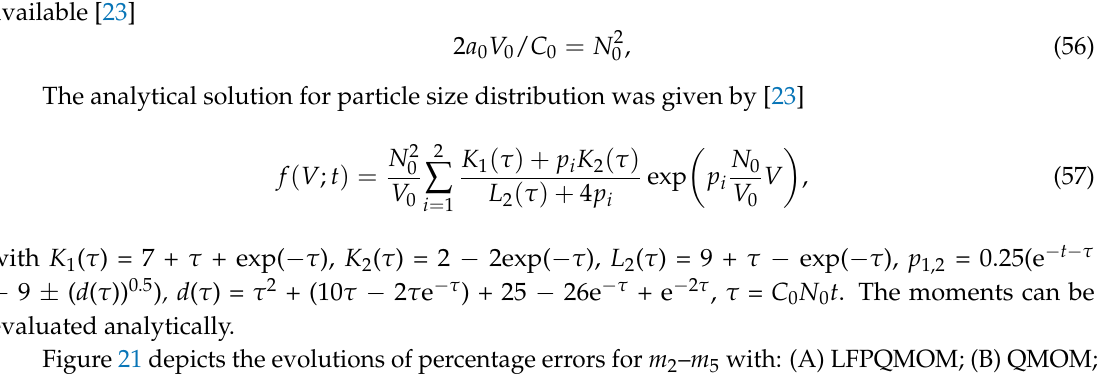
Figure 22. Particle size distributions at 0, 0.5, 2, 10, and 20 s for the aggregation and breakage combined process with constant aggregation kernel, linear breakage kernel, uniform daughter distribution, and Gaussian initial particle size distribution (square: numerical PSD at 0 s; circle: numerical PSD at 0.5 s; up triangle: numerical PSD at 2 s; down triangle: numerical PSD at 10 s; left triangle: numerical PSD at 20 s; line: analytical PSDs). 5. Conclusions In this work, a new numerical method, namely, the local fixed pivot quadrature method of moment (LFPQMOM) was proposed for the aggregation and breakage process. In the new method, particle size distribution in the local section was assumed to be a continuous summation of the Dirac Delta function with fixed pivots as performed in short time Fourier transformation (STFT). This